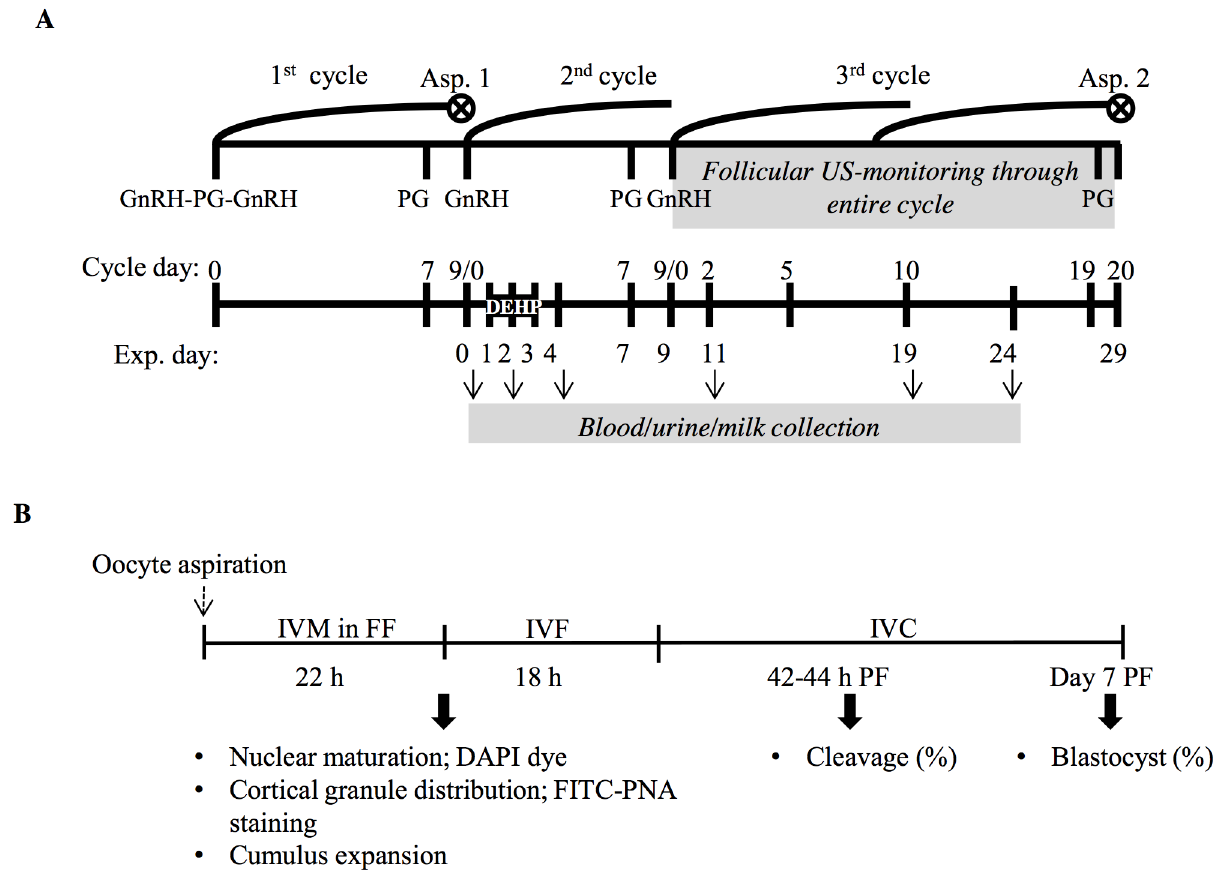
Fig 1. Schematic illustration of the experimental design. In the in-vivo part (A), cows were synchronized according to the ‘ Ovsynch ’ protocol. Cows were then divided into control (n = 5) and DEHP-treated (n = 4) groups. Samples of blood, urine and milk were collected on day 0 (before), days 2 and 4 (during) and days 11, 19 and 24 (after) DEHP administration. On day 7 of the experiment, cows were resynchronized and ovarian follicular dynamics was monitored by linear ultrasonographic scanner through the entire third synchronized cycle (days 9 to 29 of the experiment). For each experimental group, FF were pooled and analyzed for phthalate metabolite and estradiol concentrations (Asp. 1 and 2). In the second part of the study (B), FF aspirated from control and DEHP- treated cows were used as oocyte maturation medium. Cumulus oocyte complexes were aspirated and in-vitro matured in the aspirated FF (IVM in FF; 22h). Subgroups of mature oocytes were collected for examination of nuclear meiotic stages (DAPI staining), cortical granule distribution (FITC – PNA) and cumulus cell expansion. Another subgroup was in-vitro fertilized (IVF) for 18 h then in-vitro cultured (IVC) for 8 days. Oocyte developmental competence was evaluated as the proportion of oocytes that cleaved into 2- to 4-cell-stage embryos and developed to blastocysts 44 h and 7 days postfertilization,